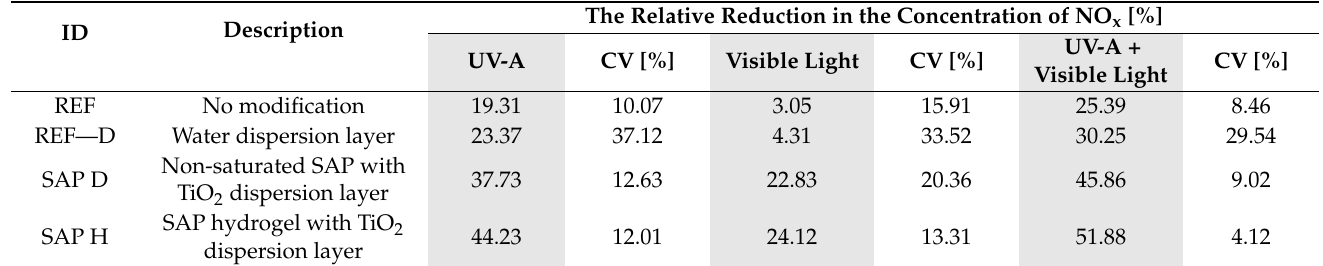
Table 5. Relative reductions in NO x concentrations in performed tests for all considered surface modification